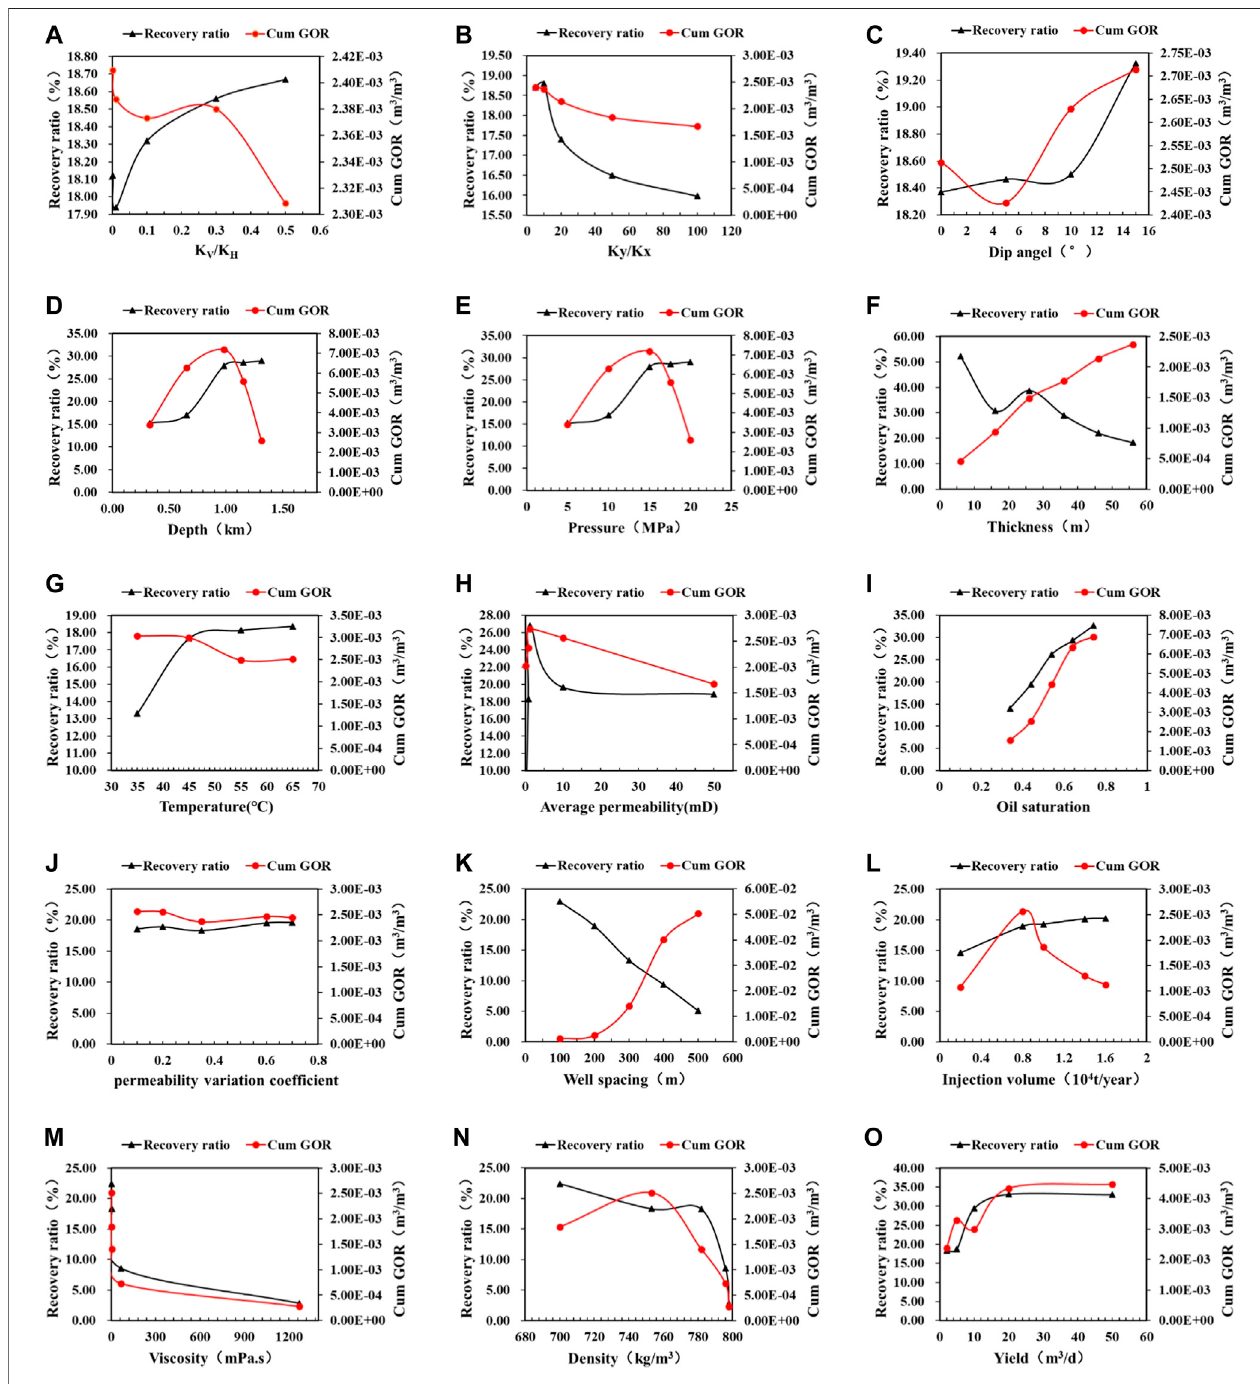
FIGURE4|(A) EffectofKV/KH; (B) effectofKy/Kx; (C) effectofdipangle; (D) effectofdepth; (E) effectofpressure; (F) effectofthickness; (G) effectoftemperature; (H) effectofaveragepermeability; (I) effectofoilsaturation; (J) effectofpermeabilityvariationcoef fi cient; (K) effectofwellspacing; (L) effectofinjectionvolume; (M) effect of viscosity; (N) effect of density; (O) effect of yield on oil recovery ratio and cumulative gas – oil